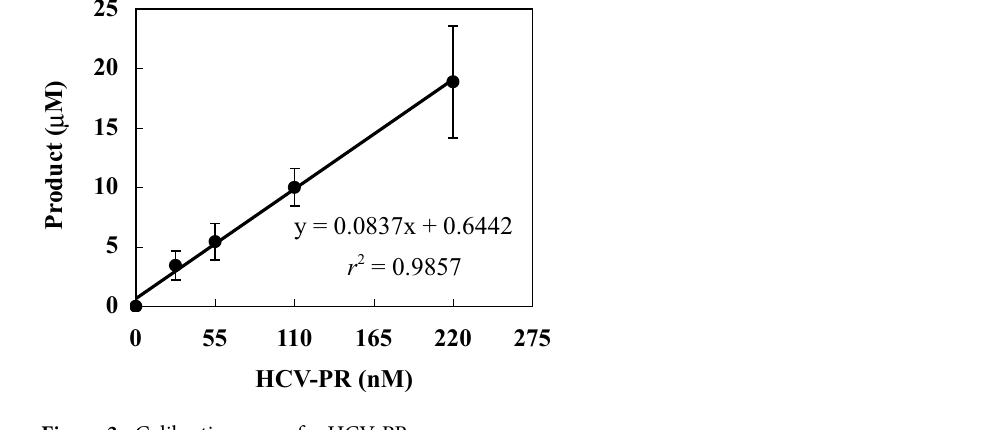
Figure 3. Calibration curve for